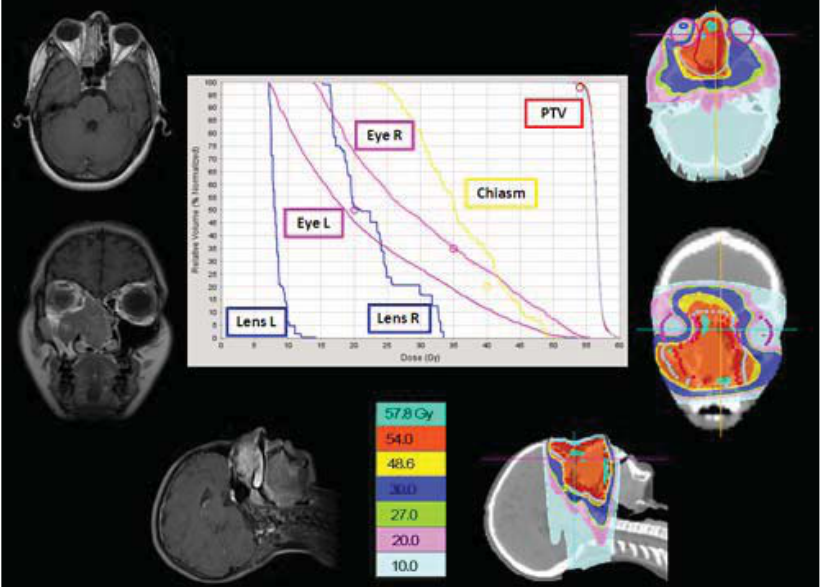
Figure 5. HT plan in an adolescent female affected by esthesioneuroblastoma of the nasal cavity offered good sparing of the contralateral optic nerve, chiasm and lens.